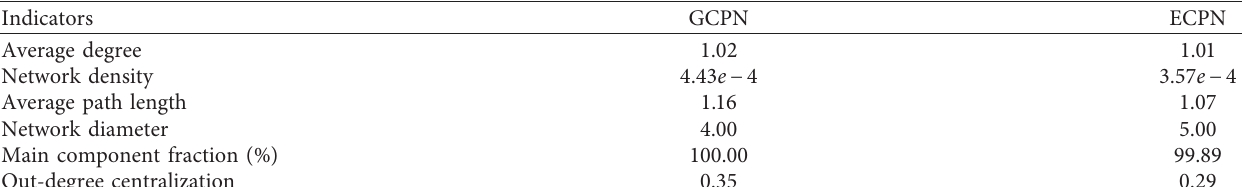
Table 1: Statistics of network characteristics.